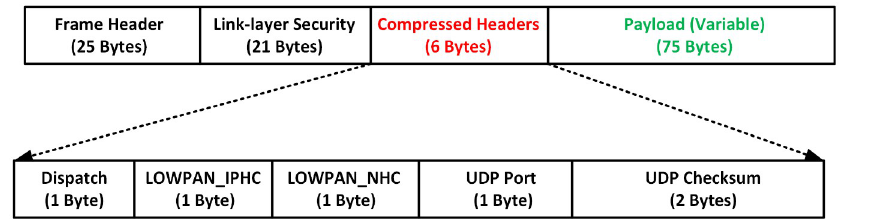
Fig 6. IEEE 802.15.4 IPv6 and datagram header